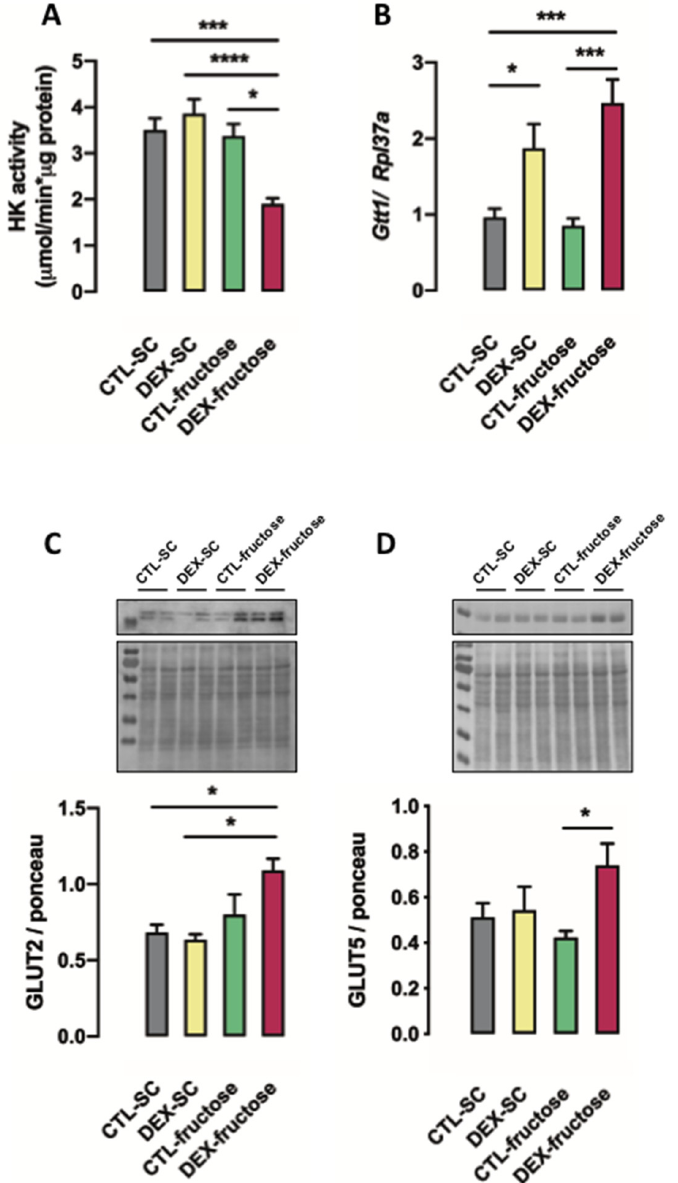
Figure 5. In utero dexamethasone (DEX) exposure alters glucose metabolism and phenotypic features of the jejunum epithelia. Scraped epithelium of jejunum fragments was isolated and processed for measurement of maximum hexokinase activity ( A ), expression of glutathione S-transferase 1 (Ggt1) by quantitative polymerase chain reaction (qPCR) ( B ), and Western blot of facilitated glucose transporter member 2 (GLUT2) ( C ) and facilitated glucose transporter member 5 (GLUT5) ( D ). Results are presented as mean ± standard error of the mean (S.E.M.). * p < 0.05, ** p < 0.01, *** p < 0.001, **** p < 0.0001 ( n = 6–12). Offspring born to control (CTL) mothers that received only standard chow (SC) and tap water during adult life (CTL-SC); offspring born to DEX-treated mothers that received only SC and tap water during adult life (DEX-SC); offspring born to CTL mothers that received SC plus 10% fructose during adult life (CTL-fructose); and offspring born to DEX-treated mothers that received SC plus 10% fructose during adult life (DEX-fructose).